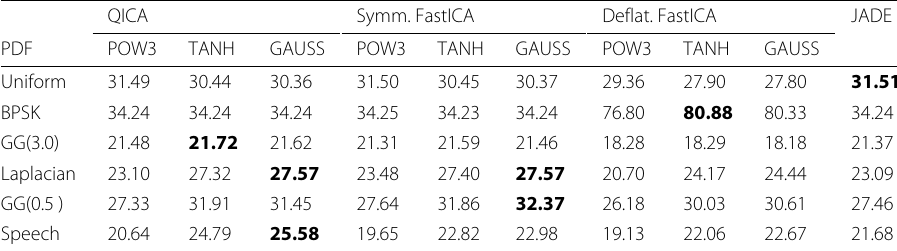
Table 1 Average SIR (dB) for 4 components with the same distribution, after k = 40 iterations QICA Symm. FastICA PDF